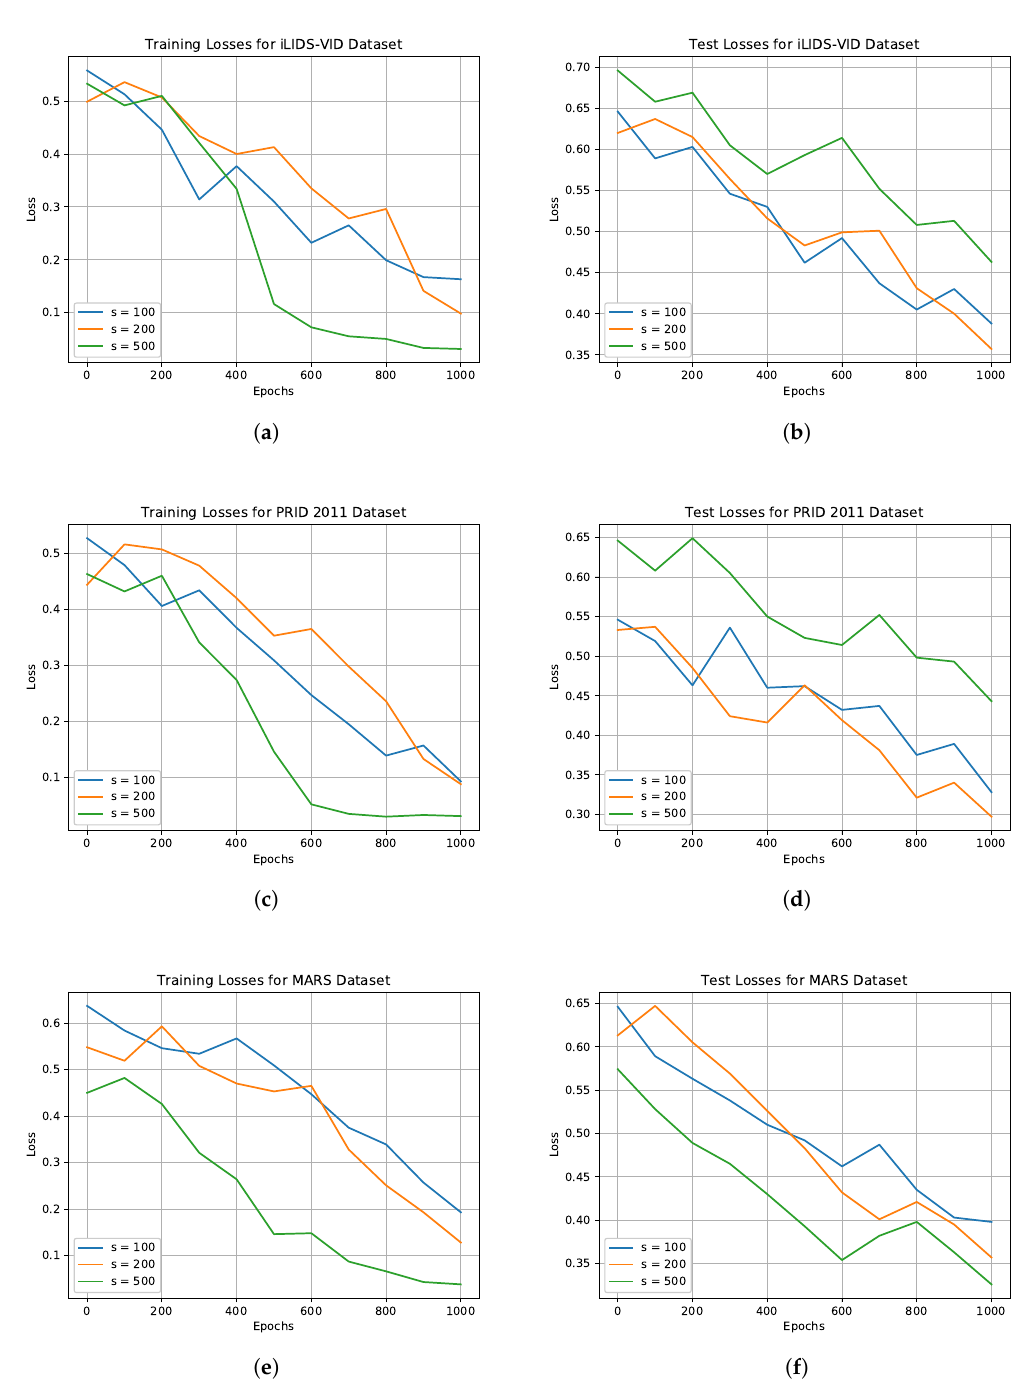
Figure 3. Train (left column) and test (right column) losses of the proposed method obtained on: iLIDS-VID, PRID 2011, and MARS datasets. Performances for these three datasets are summarized in ( a , b ), ( c , d ), and ( e , f ), respectively. By increasing the LSTM representational power (i.e., s size) convergence on the training set is reached much faster (i.e., ( a , c , e ) figures). However, due to the low number of identities in iLIDS-VID and PRID 2011 datasets, the highest s amount (i.e., 500) might result in overfitting scenarios (i.e., ( b , d )